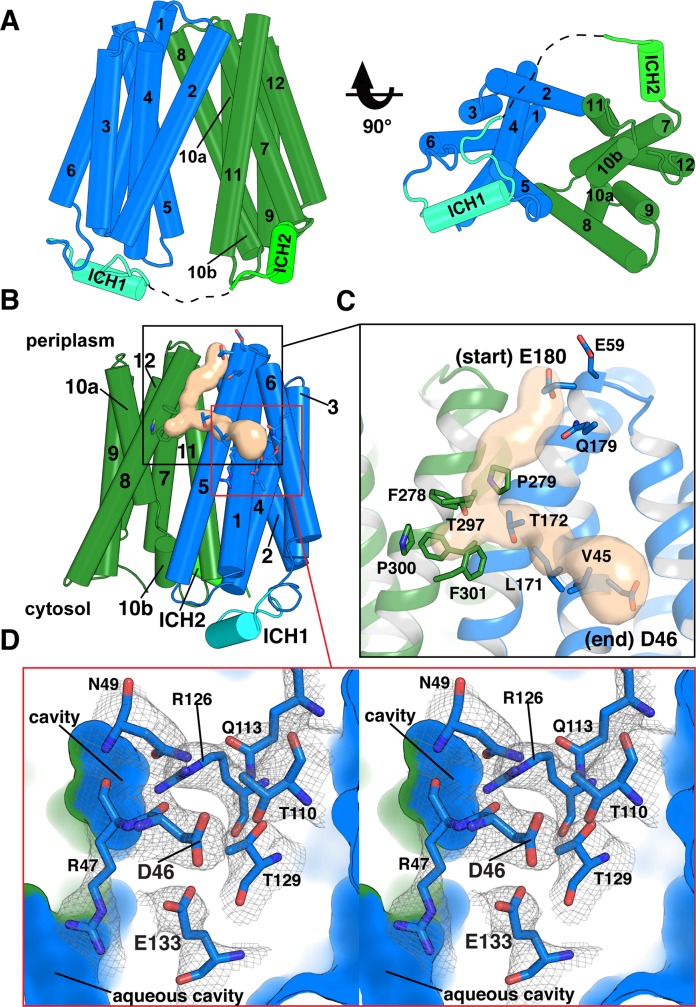
The inward-open structure of DgoT shows a proton translocation pathway connected to the periplasm.(A) Cylinder representation of inward-facing DgoT viewed parallel to the membrane plane and from the cytoplasm. Helices are numbered from the N to C terminus. Dotted line represents unstructured regions. (B) Overall view of inward-facing DgoT in cylinder representation shows the putative water tunnel (tan surface) with the surrounding residues shown as sticks. (C) A close-up view of the tunnel highlights the entrance and exit points. (D) Putative sites of protonation (Asp46 and Glu133) lie in a membrane-embedded pocket of polar residues buried within the NTD (crossed-eye stereo). The polar and charged residues composing the pocket are shown as sticks. Electron density is from a composite, simulated annealing “omit map” to eliminate model bias (1σ). Outer surface and cavities formed from interdomain contacts are shown in blue (NTD) and green (CTD). Asp46, aspartate-46; CTD, C-terminal domain; DgoT, D-galactonate transporter; Glu133, glutamate-133; ICH, intracellular helix; NTD, N-terminal domain.